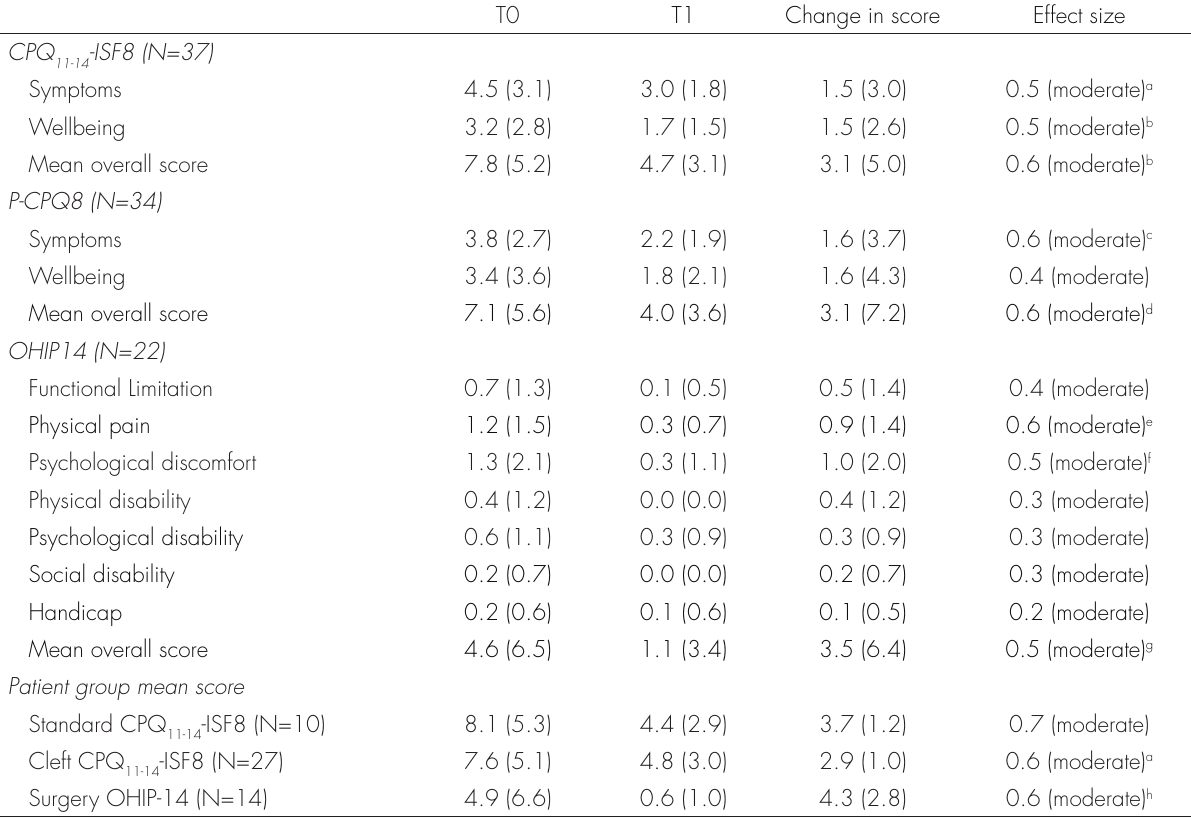
Table III. Changes in mean OHRQoL scale and domain scores from appliance removal (T0) to three months post-removal follow-up (T1) (brackets contain standard deviations, unless otherwise